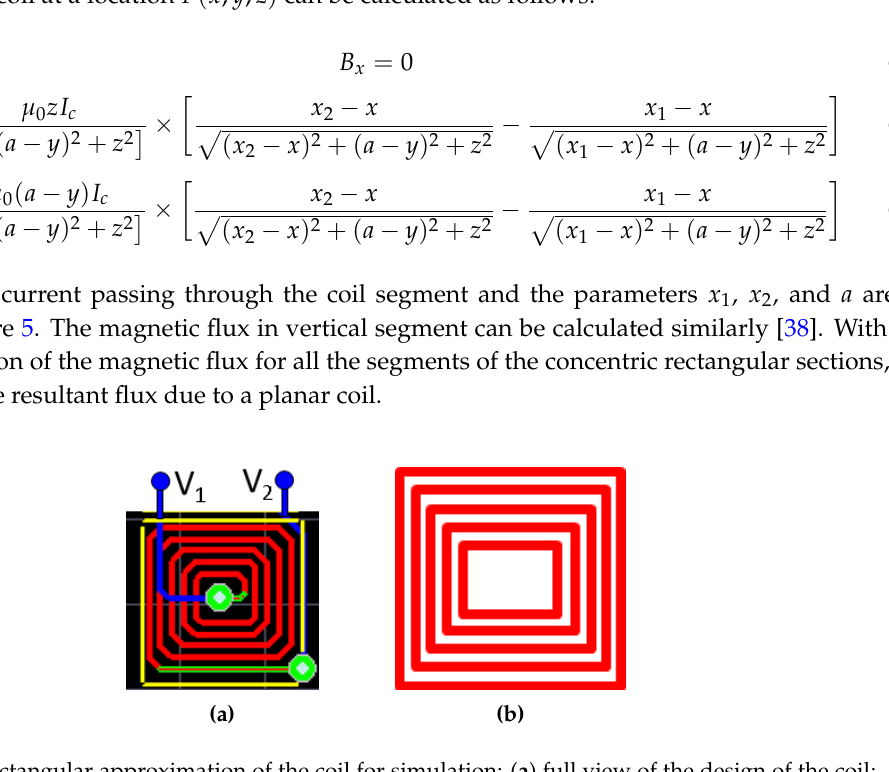
Figure 4. Rectangular approximation of the coil for simulation: ( a ) full view of the design of the coil; ( b ) concentric rectangular approximation of the coil.